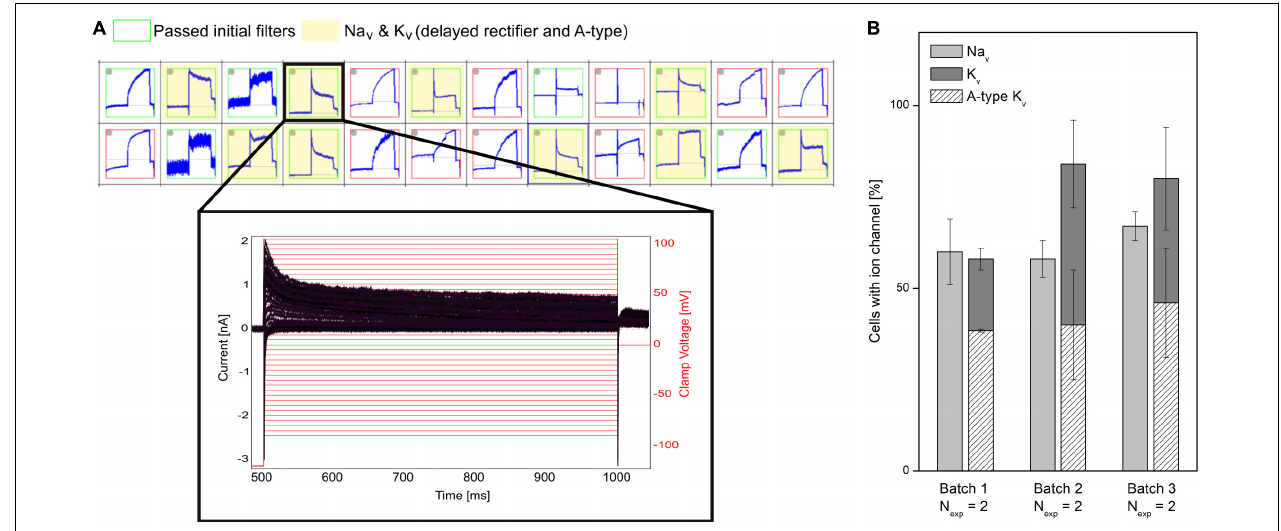
FIGURE 4 | Characterizing mixed ion channel populations in hiPSC-derived cortical neurons. (A) Quality control filters allow selection of cells expressing the ion channels of interest. Top: Cut-out of the measurement plate view showing 24 of 384 experiments. Red and green borders correspond to experiments that failed and passed, respectively, the initial filter criteria ( R mem > 500 M (cid:127) , C cell > 1.5 pF). The experiments highlighted in yellow passed filter criteria for Na v and K v currents. Bottom: Example of a population of current traces (black) elicited by + 5 mV voltage-steps (red) recorded from a neuron, expressing Na v channels and a mixture of delayed rectifier and A-type K v channels. (B) The percentage (average ± SEM) of investigated cells containing Na v and K v channels were displayed for three different differentiation batches of hiPSC cortical neurons ( N exp = 2 experiment days, with > 48 measurement sites per experiment). Of the cells expressing K v channels, the percentage of K v expressing cells also having A-type K v currents are overlayed (diagonal pattern). No significant differences were observed between the three batches (Rosholm et al., 2021b). Adapted from Rosholm et al. (2021b), with permission from Sophion Bioscience A/S.